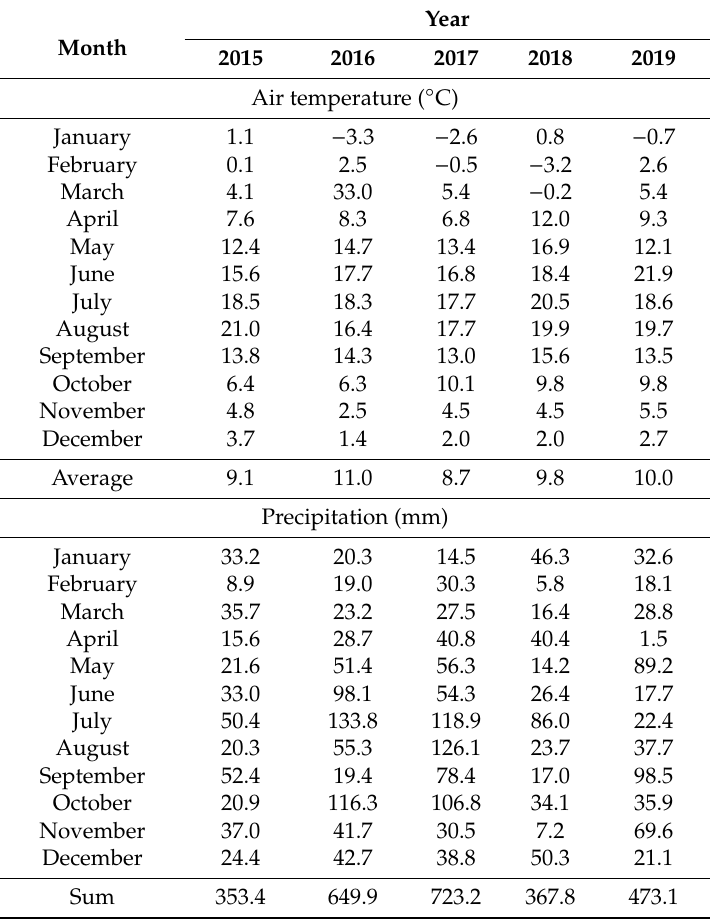
Table 1. Meteorological conditions in 2015–2019 at the site of field